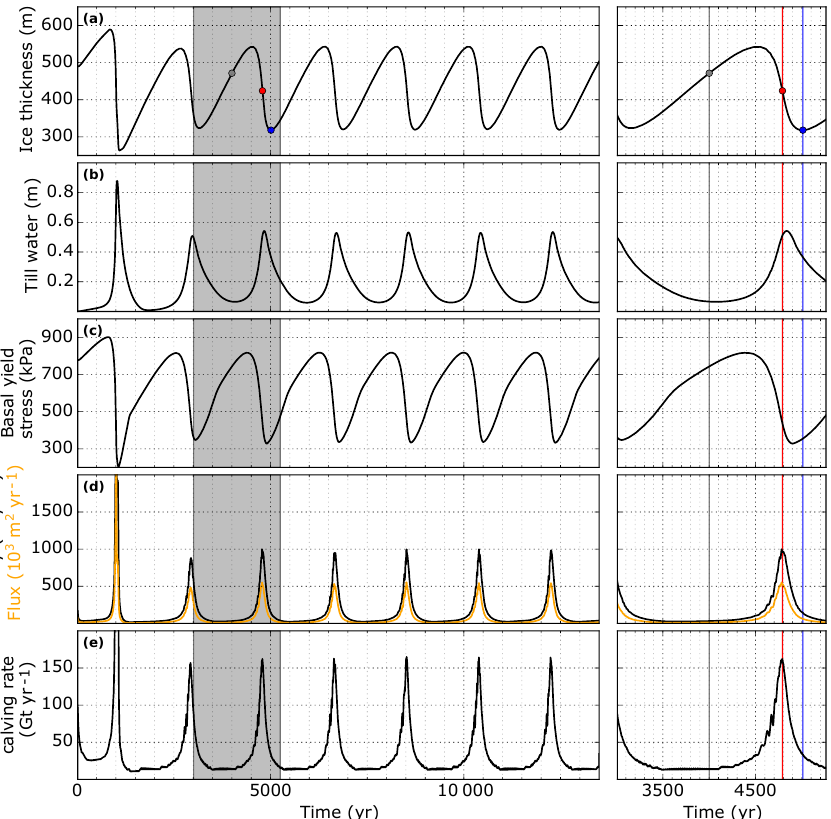
Figure 3. Time series of the main variables which characterize the feedback loops of growth, surge and stabilization in Fig. 2. (a) Ice thickness H , (b) till water thickness W till , (c) basal yield stress τ c , (d) velocity and ice flux (orange) and (e) iceberg calving rate. Except for the calving rate, data shown is averaged over the area of grounded ice. The calving rate has been smoothed with a 200-year moving window. The right-hand side of each panel shows a zoom into a full cycle (highlighted in gray). Colored circles in panel (a) show the points in time chosen to be representative for the phases of buildup (gray), surge (red) and stabilization